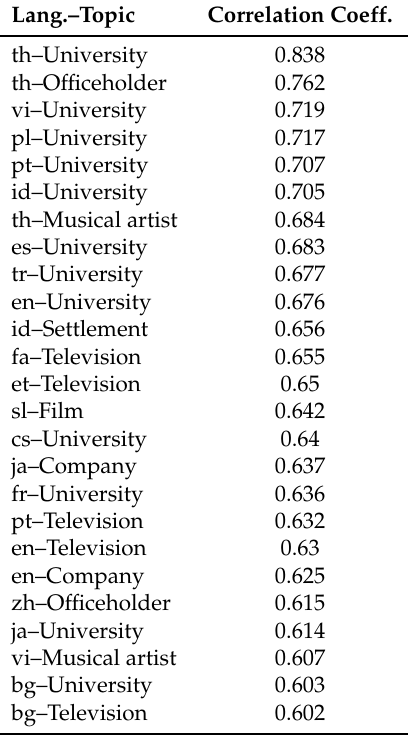
Table 11. Top 25 language versions and topics with the highest phi coefficients between articles with the highest quality and popularity (articles with at least three language versions were considered). Source: own calculations.